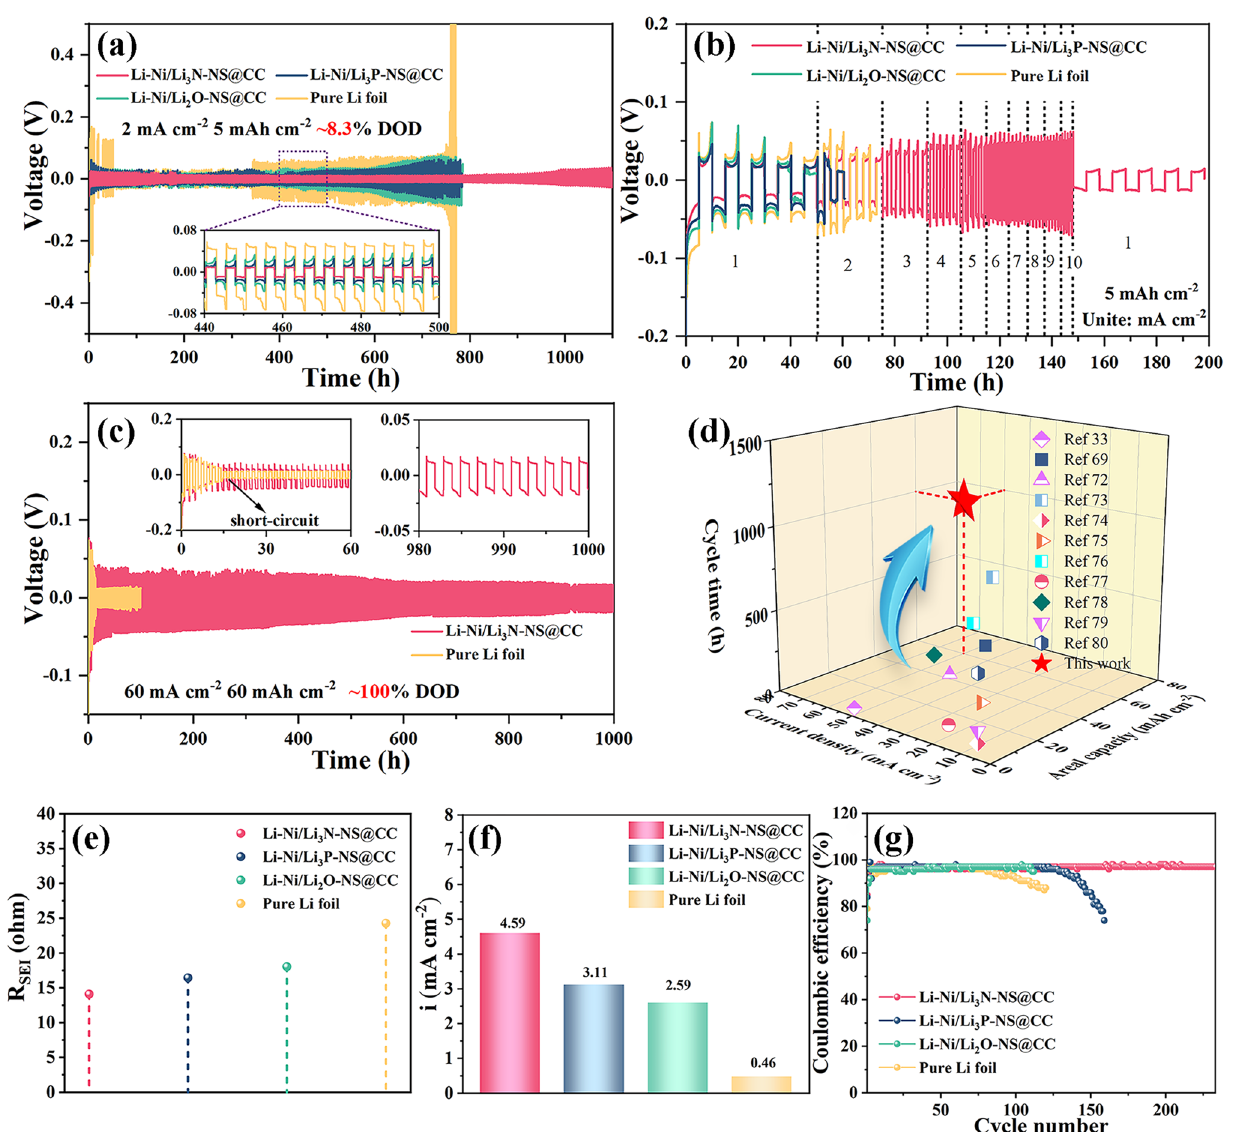
Fig. 4 a Voltage–time profiles of symmetrical batteries with the Li-Ni/Li 2 O-NS@CC, the Li-Ni/Li 3 N-NS@CC, the Li-Ni/Li 3 P-NS@CC, and pure Li electrodes at 2 mA cm −2 , 5 mAh cm −2 . b The rate performance of the above electrodes obtained at different current densities, respec- tively. c The voltage–time profiles of symmetrical batteries with the Li-Ni/Li 3 N-NS@CC and pure Li electrodes at 60 mA cm −2 , 60 mAh cm −2 . d Long-cycle performance comparison of symmetrical battery with the Li-Ni/Li 3 N-NS@CC electrode and other published works recently. e The comparison of R SEI of the above electrodes after cycling. f The comparison of exchanging current density among various samples. g A com- parison of CE of Li||Cu batteries based on the Li-Ni/Li 2 O-NS@CC, the Li-Ni/Li 3 N-NS@CC, the Li-Ni/Li 3 P-NS@CC and pure Li electrodes at 1 mA cm −2 , 1 mAh cm −2 (counter electrode: Cu